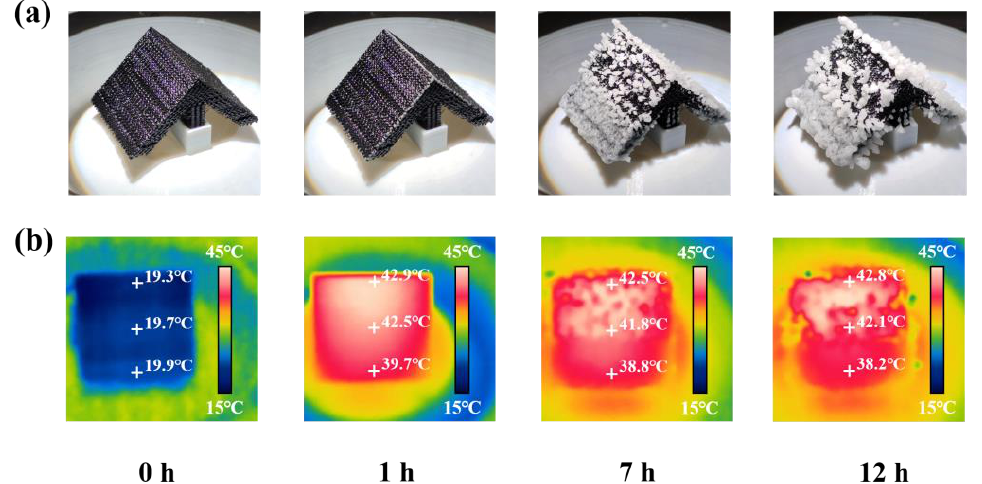
Figure 9. During 12 h operation of the crystallizer: ( a ) Digital photograph of salt crystallization; ( b ) infrared thermal images.